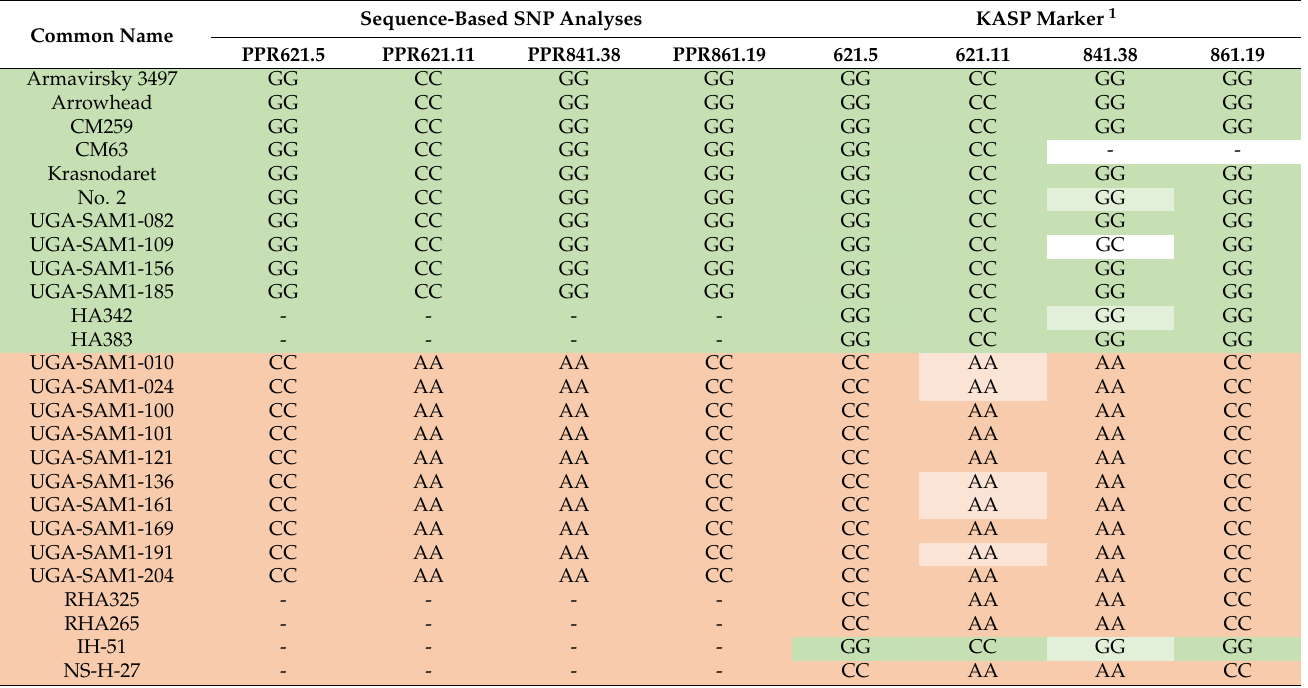
1 Green are maintainer lines, red are restorer lines; light green and light red represent SNPs with a weaker